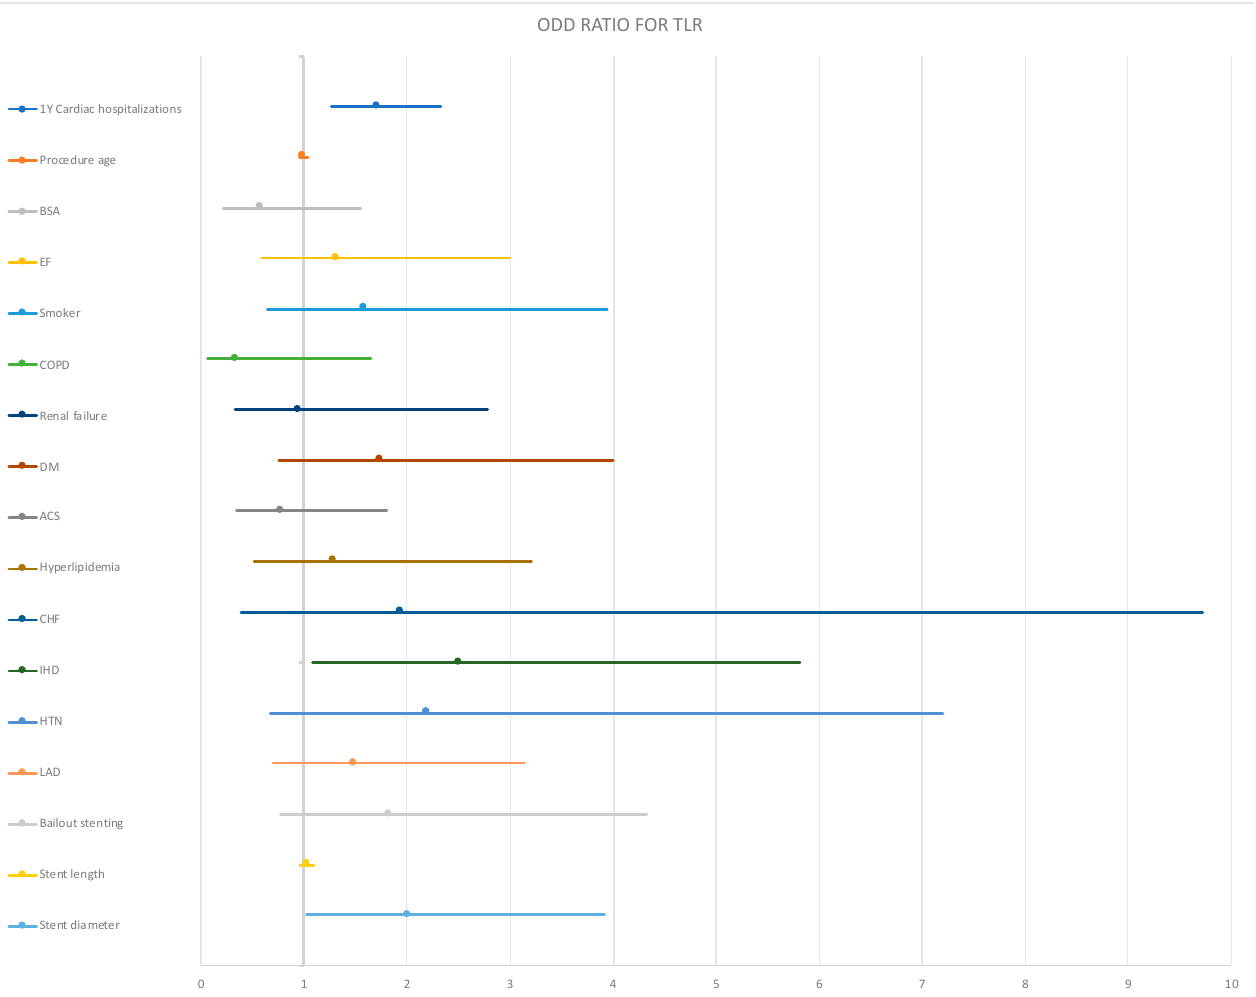
Figure 3. Subgroups analysis. BSA = body surface area; LVEF = left ventricle ejection fraction; COPD = chronic obstructive pulmonary disease; DM = diabetes mellitus; ACS = acute coronary syndrome; HF = heart failure; IHD = ischemic heart disease; HTN = hypertension; LAD = left anterior descending artery.